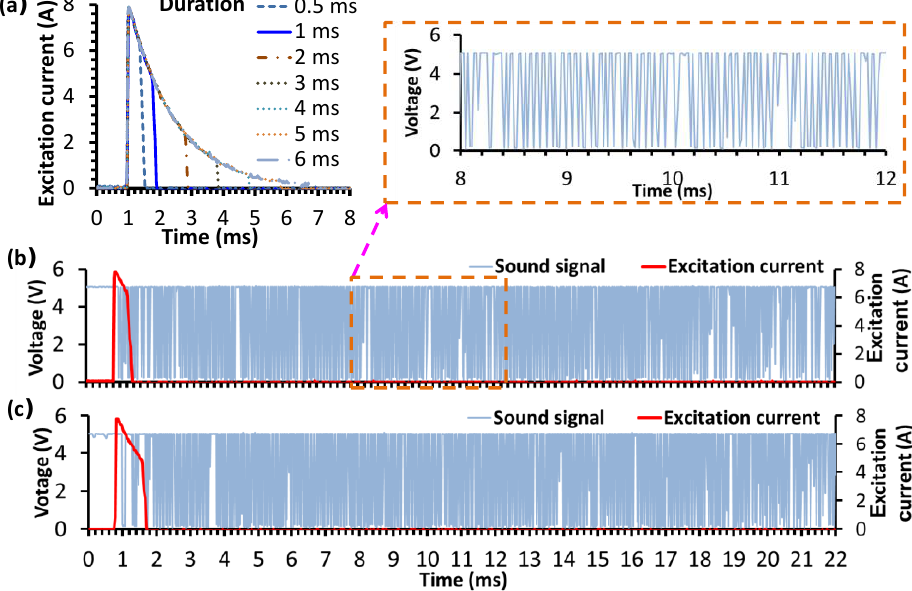
Figure 6. ( a ) The current pulse duration; the sound signal of coin No.1 after transforming the circuit with the different acting durations: ( b ) 0.5 ms, and ( c ) 1 ms. Under the excitation current pulse, the eddy current is induced inside the coin im- mersed in the static magnetic field to generate the non-contact impulse force. To esti- mate the force on the coin, the distribution of eddy current density inside the coin is simulated using the finite element software ANSYS. Figure 7 shows the distribution of eddy currents at 0.5 ms after the 8-A excitation pulse is applied. It is found that the eddy current flows along the circumferential direction with the maximum intensity occurring near the edge, as shown in Figure 7a. The eddy current concentrates near the coin ’ s out- er edge, where the radial component of the static magnetic field is also maximized. On the central cross-section, the maximum eddy current density is 2.6 A/mm 2 at the position right above the spiral coil, as shown in Figure 7b. The total Lorentz force, which is esti- mated by integrating (1) over the volume of the coin, is 0.4 N perpendicular to the coin’s surface. As the impulse force concentrates on the rim of the coin, the coin will vibrate in a (0,1) mode, as described in (3). (b) Figure 7. Simulated eddy current distribution in the coin at 0.5 ms after the excitation current pulse is applied: ( a ) current density vectors inside the coin; ( b ) intensity of current density on the central cross section of the coin. The horizontal range for the cross section is 28 mm.